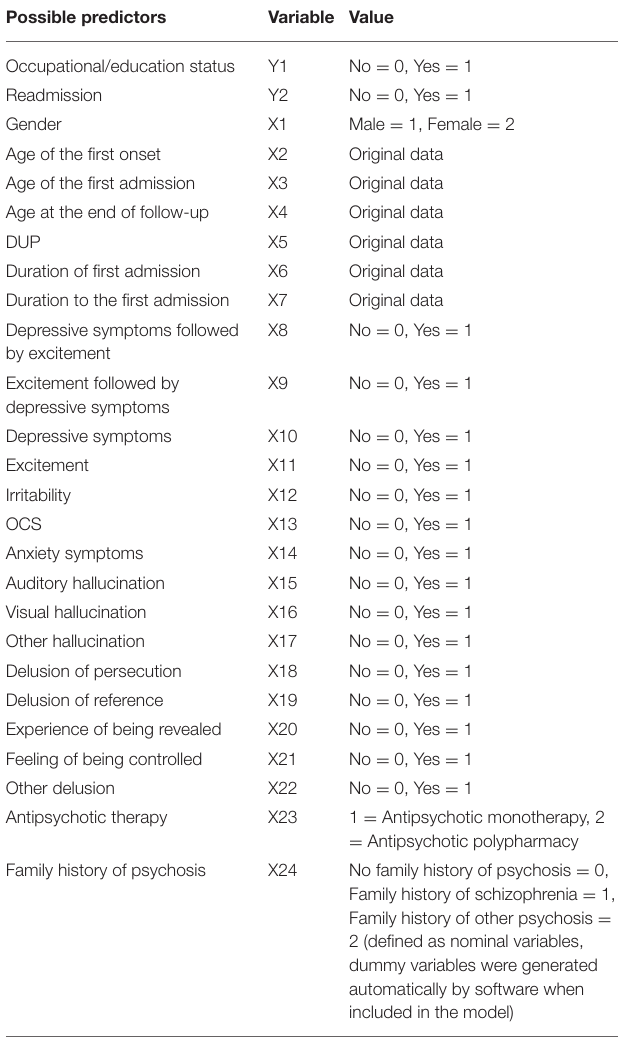
TABLE 3 | Possible predictors of COS outcomes and their